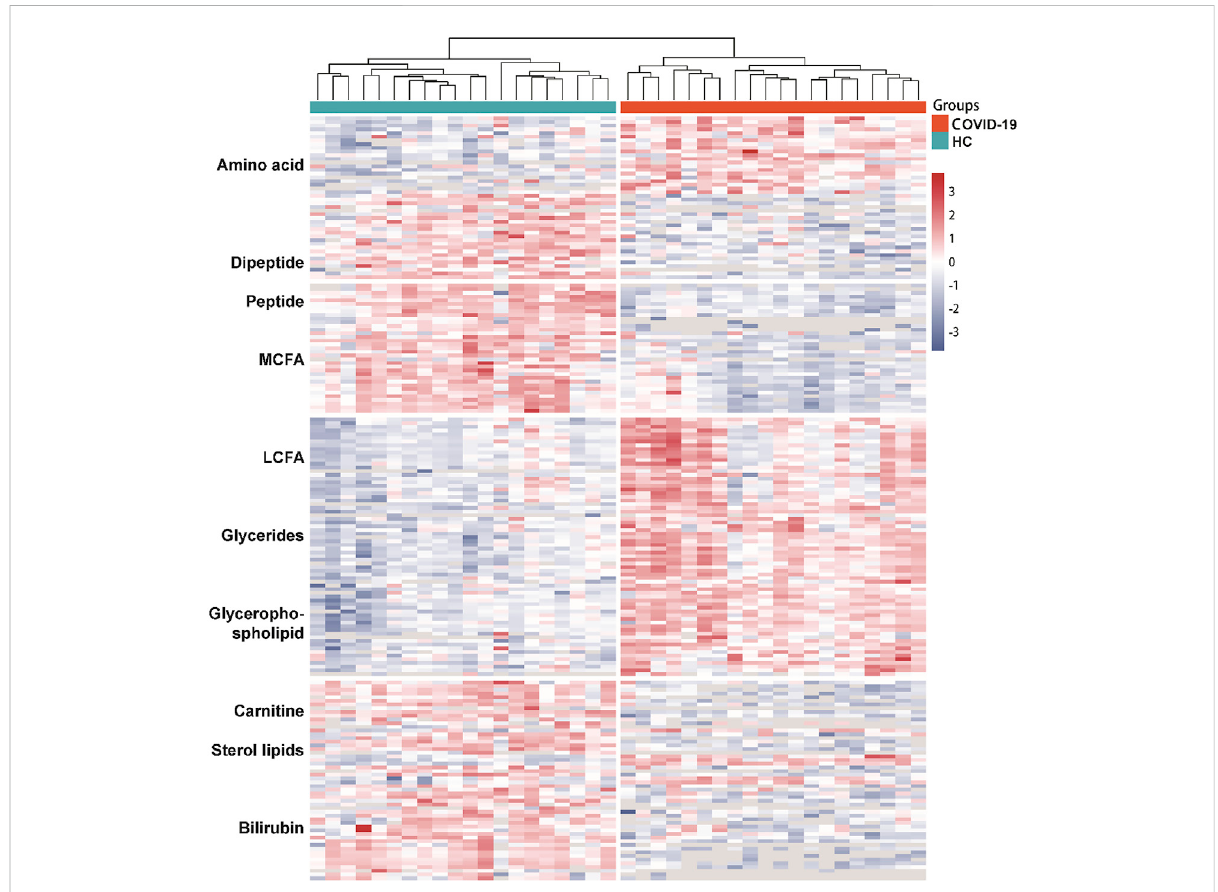
FIGURE 3 Dysregulated Metabolites in the serum of COVID-19 patients. Heatmap visualization of signi fi cantly altered metabolites between COVID-19 group and healthy controls. Metabolites included in the heatmap meet the requirement that fold-change > 1.5 or < 0.67 and adjust p value of < 0.05. The color bar represents the relative intensity of identi fi ed proteins from − 3 to